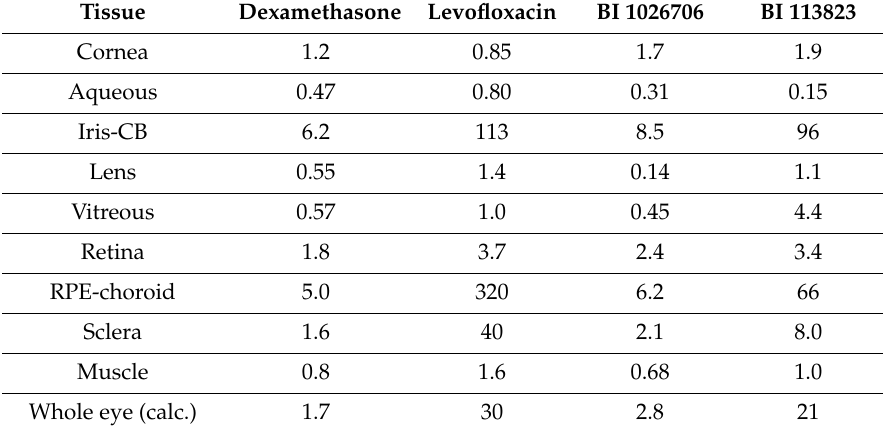
Table 3. Ratio of Kp values between pigmented BN and albino WH rat (BN / WH ratio). The ratios were calculated from the average Kp values. Whole eye value was calculated (calc.) with hypothetical volumes (Table S3) for the individual